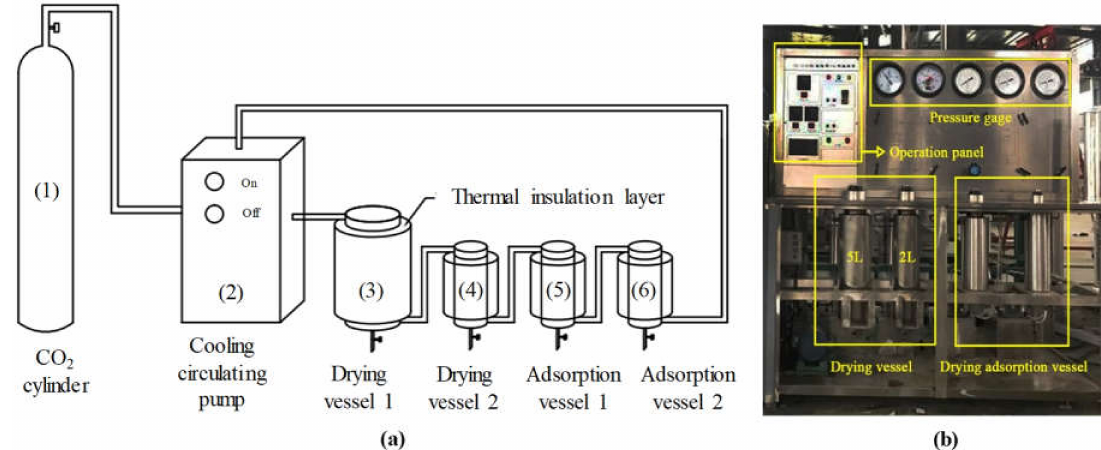
Figure 1. Supercritical CO 2 dewatering system. ( a ) Sketch map and ( b ) localized photo.